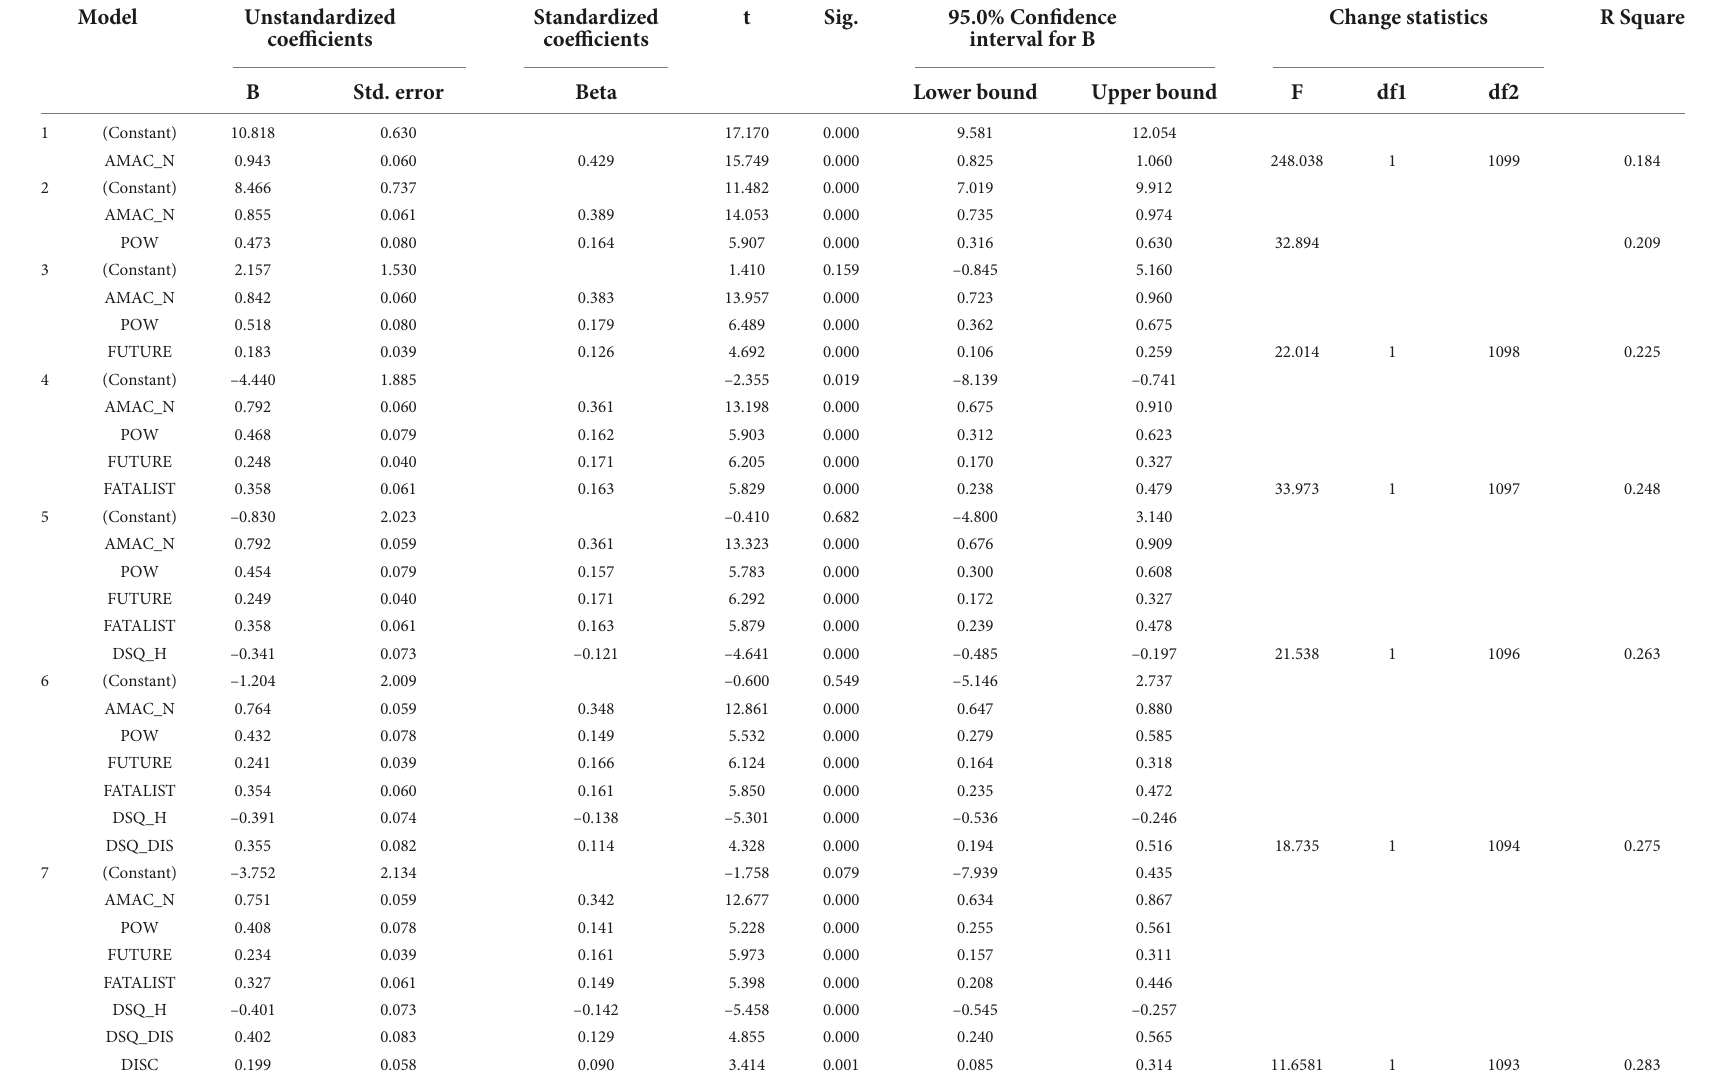
TABLE 3 Stepwise regression analysis among the COVID-19 conspiracy scale and the examined